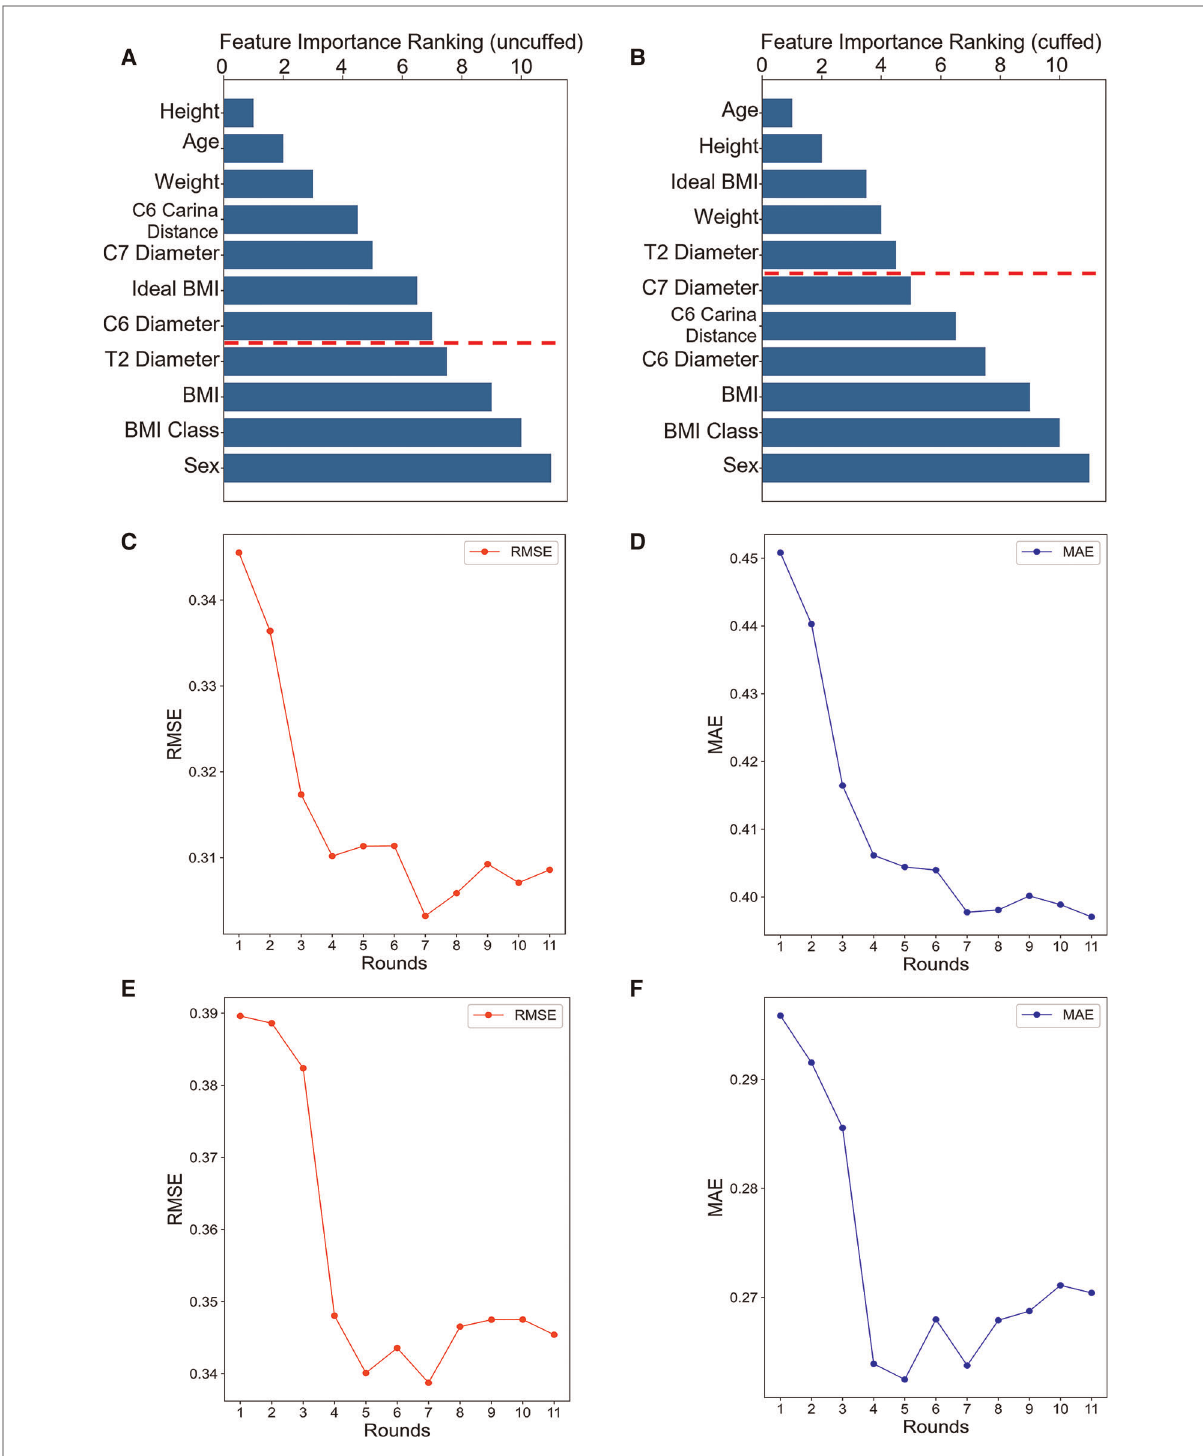
FIGURE 3 Feature importance ranking and forward feature selection results. The bar graph shows the importance ranking of variables usd for uncuffed ETT ( A ) and cuffed ETT ( B ) size prediction. The shorter the transverse column, the greater importance of the median ranking of the variable. The fi nally selected features were indicated above the red line. The line graphs show the forward feature selection results for uncuffed ETT ( C-D ) and cuffed ETT ( E-F ) size prediction. We examined the performance of the most prominent feature and identi fi ed the point at which there was no considerable decrease in RMSE and MAE, when adding the feature of the next highest ranking one to the model. As can be seen from the graph, the seventh feature is the lowest point in uncuffed ETT size prediction and the fi fth is the lowest point in cuffed ETT size predciton. BMI: body mass